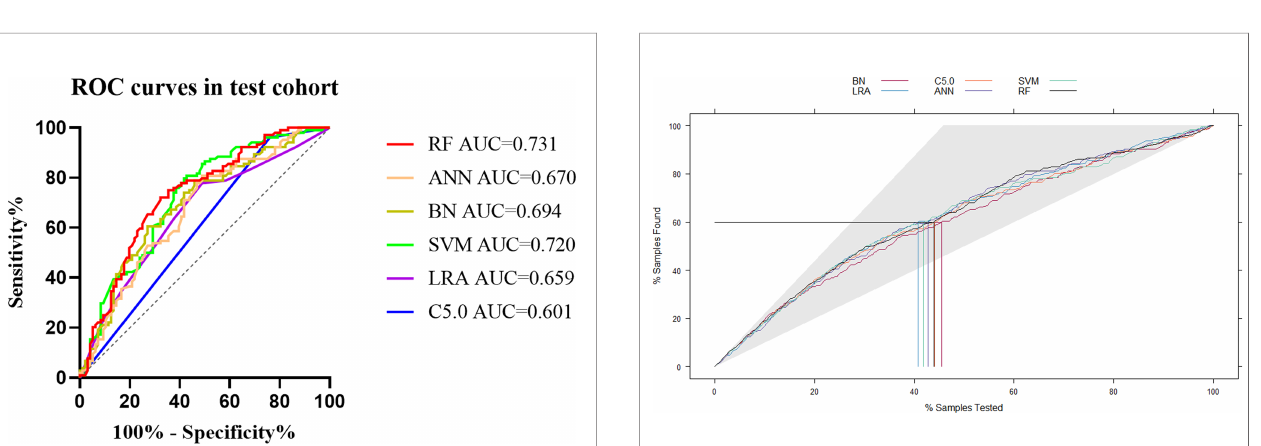
FIGURE 3 | The mixed Lift curves of the six machine learning models in the test cohort. The Lift curve is one of the most commonly used methods for data mining classi fi ers. Unlike the ROC curve, Lift curve considers the classi fi er ’ s accuracy: the ratio of the number of positive classes obtains using the classi fi er to the number of positive classes obtains randomly without using the classi fi er. The Lift curve drawing process is similar to the ROC curve, and the difference is that Lift value and robust planar pose change in the opposite direction, which forms the opposite form of Lift curve and ROC curve. In the current mix Lift curves, RF also has the best diagnostic performance. ROC, receiver operating characteristic; RF, random